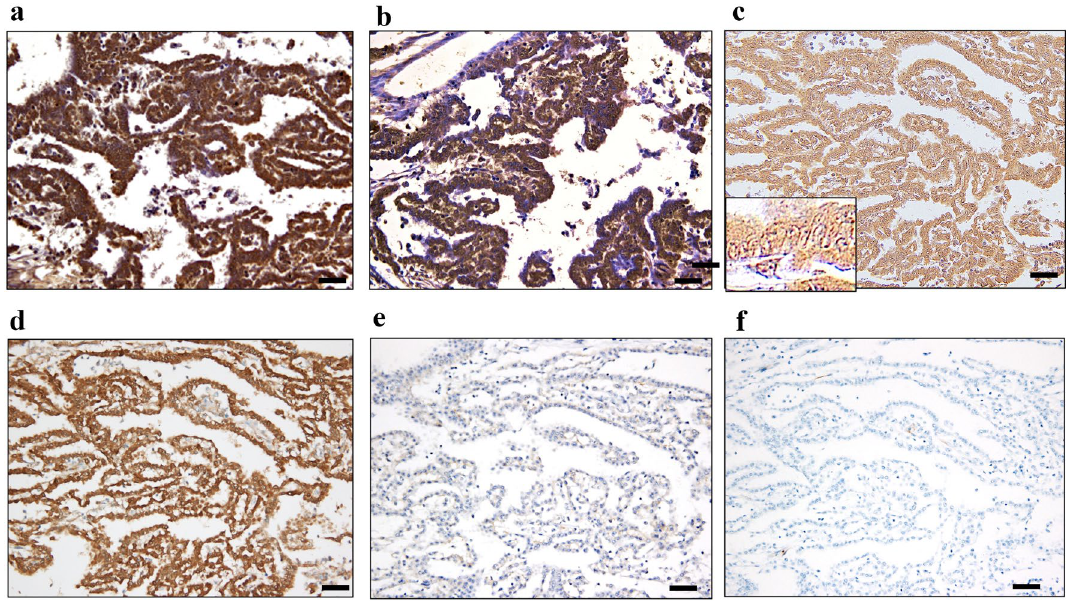
Figure 1. Immunohistochemistry of tissue samples from one representative case of malignant mesothelioma. ( a ) RhoA, ( b ) vigilin, ( c ) D2-40, ( d ) calretinin, ( e ) BAP1, ( f ) WT1. Scale Bars show 50 μm. Original magnification is × 200 for all except the inset photo in ( c ) (× 400).